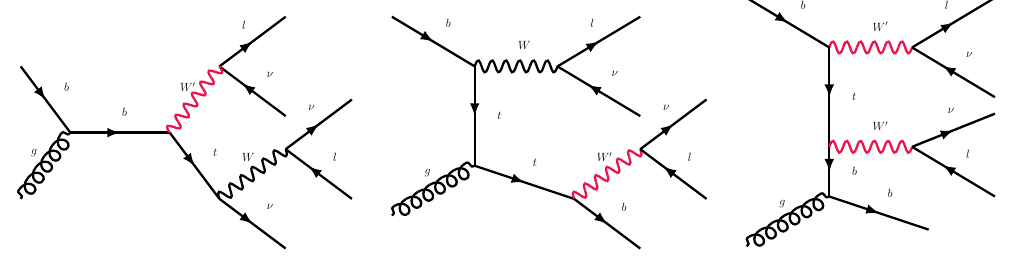
Figure 3 . Representative leading order LQ model diagrams for pp shown in red.